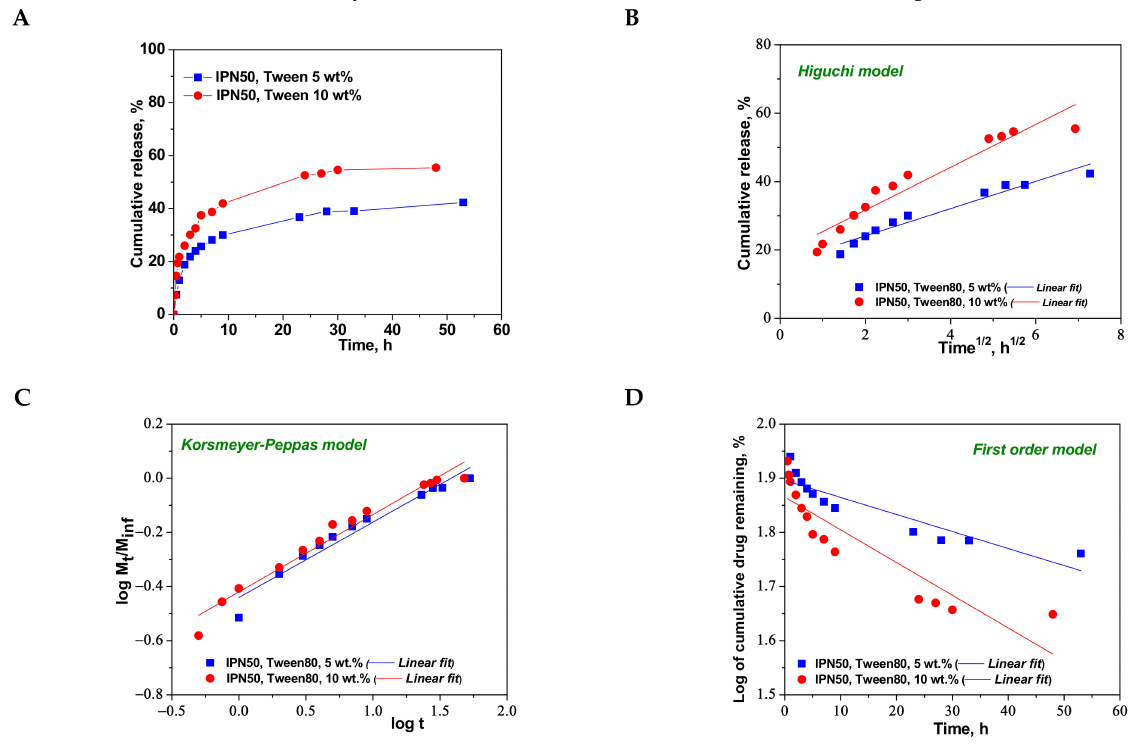
Figure 10. Cumulative release of CCM at pH 3.0, and 37 ◦ C, from IPN50 ( A ); fitting of kinetic models: Higuchi ( B ), Korsmeyer–Peppas ( C ), and first order ( D )